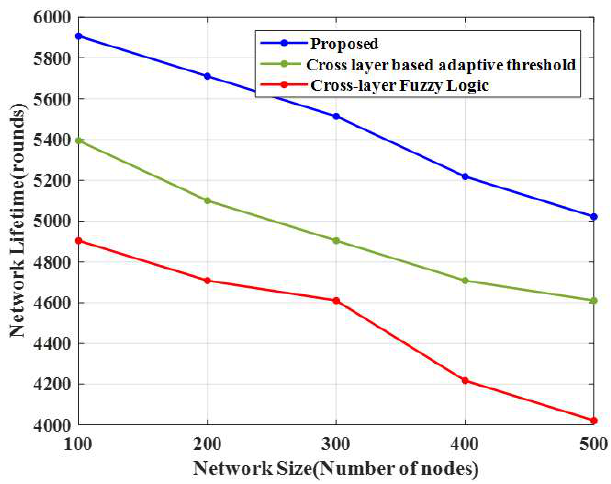
Figure 6. Comparison of the network lifetime. Table 4. Energy consumption and network lifespan.